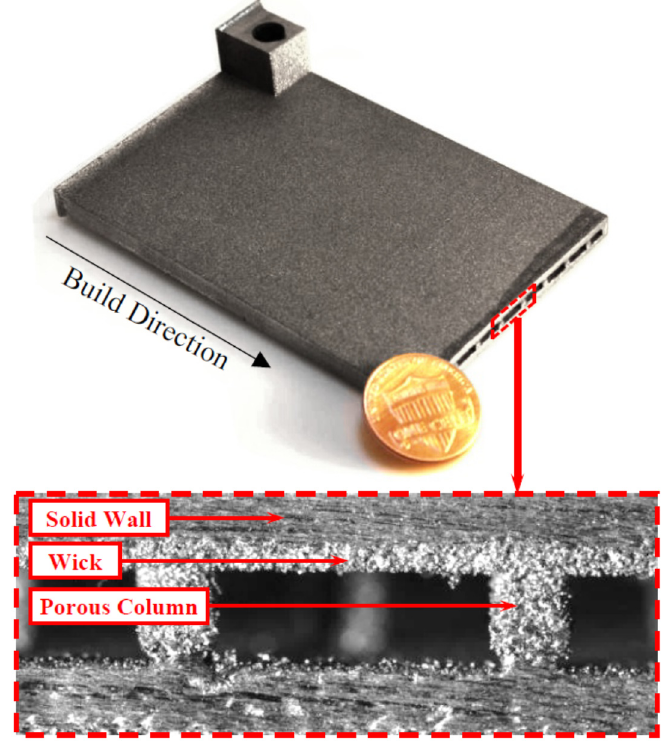
Figure 17. Photograph of the 3D-printed vapour chamber sample with a section cut across the width and inset view of the internal, as-printed structure [43].